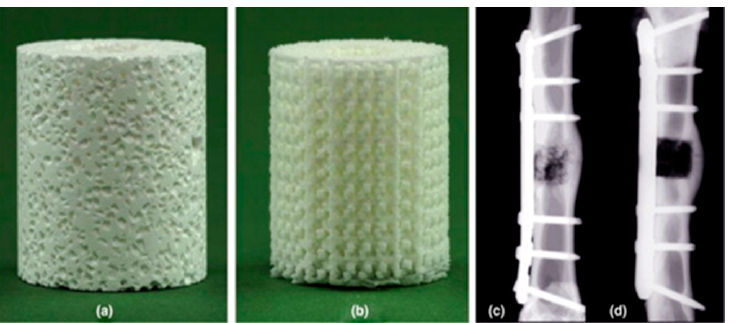
Figure 10. Commercial β -TCP implant ( a ) and PCL/TCP scaffolds built by SLS ( b ). X-ray images of tibia defects treated with β -TCP ( c ) and PCL/TCP ( d ) scaffolds after 14 weeks of implantation. Reprinted from Ref. [176] with permission from Acta Biomater.